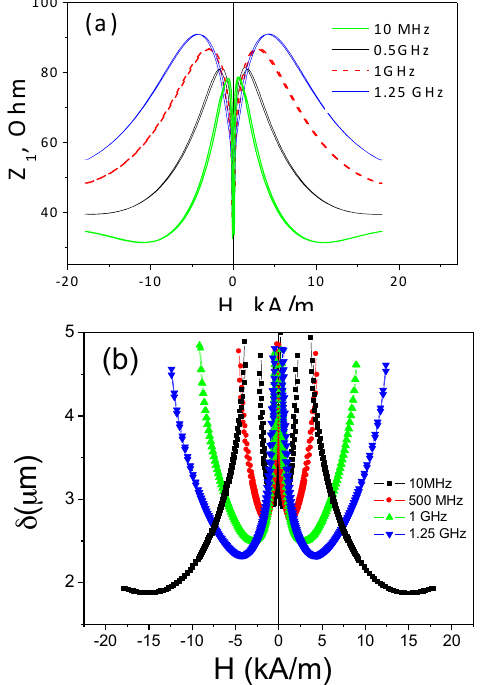
Fig.2. Z(H) dependence (a) and calculated δ (H) dependences (b) of Co microwires estimated for different frequencies minimum calculated penetration depth is below 0.5 µ m for high frequencies (Fig.3b). From obtained δ (H) dependences we evaluated δ -values and dependence of minimum δ - values on frequency (see Fig.3c). As can be appreciated from Fig.3c minimum δ -values, δ increasing the frequency and at 2 GHz δ (Fig.3c).